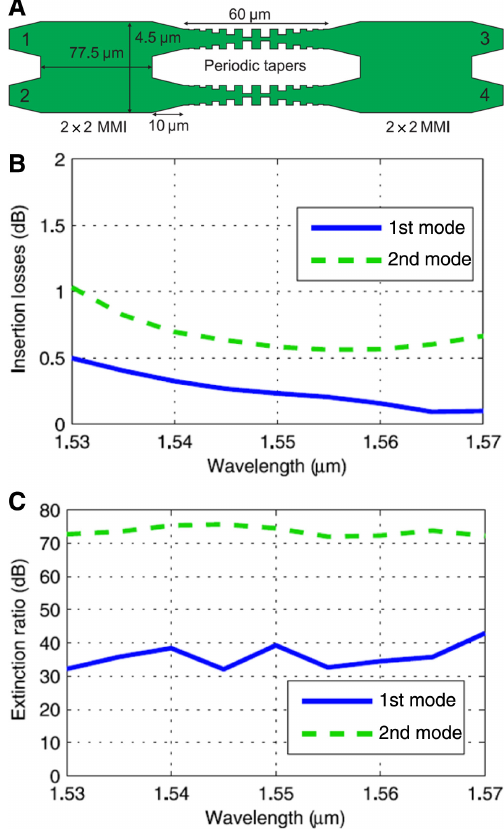
Figure 10: Theoretical study of an add/drop mode multiplexer. (A) Schematic diagram of the mode multiplexer based on MMIs and an MZI coupler with SWG waveguides in both arms. Simulated device performance of the (B) IL and (C) ER as a function of wavelength. Reprinted from Pérez-Galacho et al. [47]. Copyright © 2015 by the